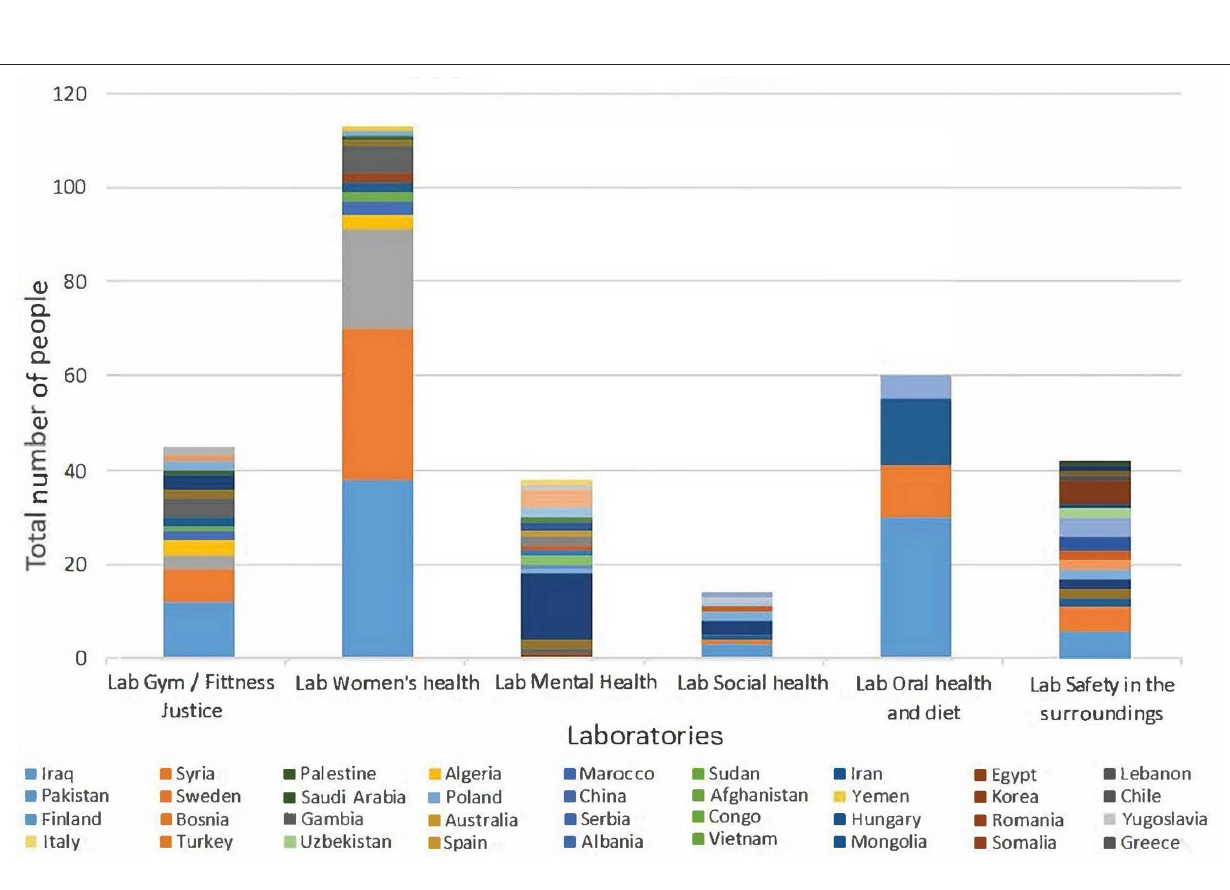
FIGURE 2 | Participants by country of origin and